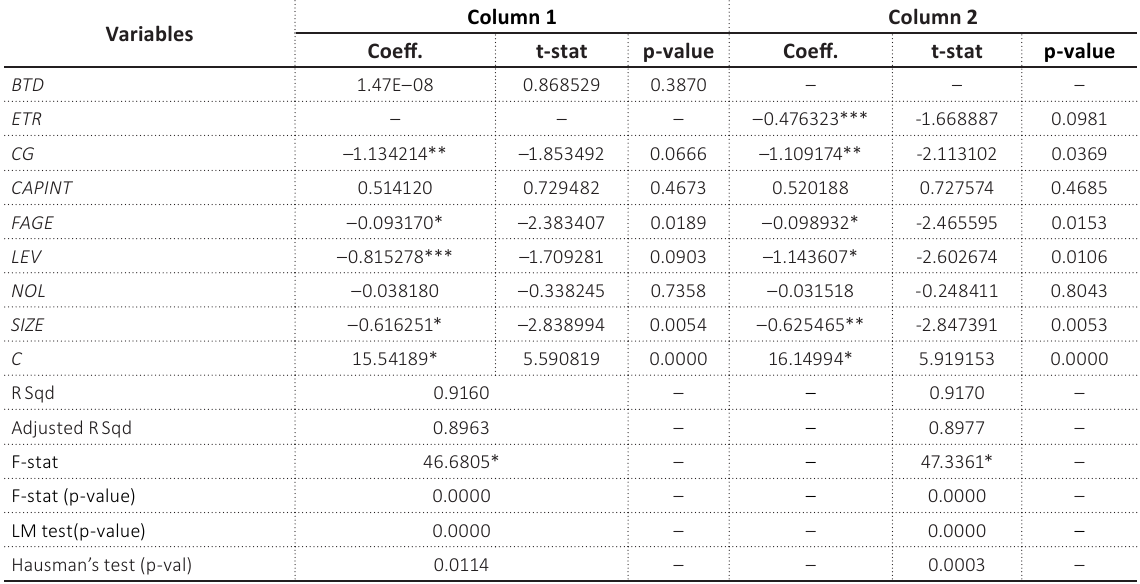
Table 2. Panel estimation (without